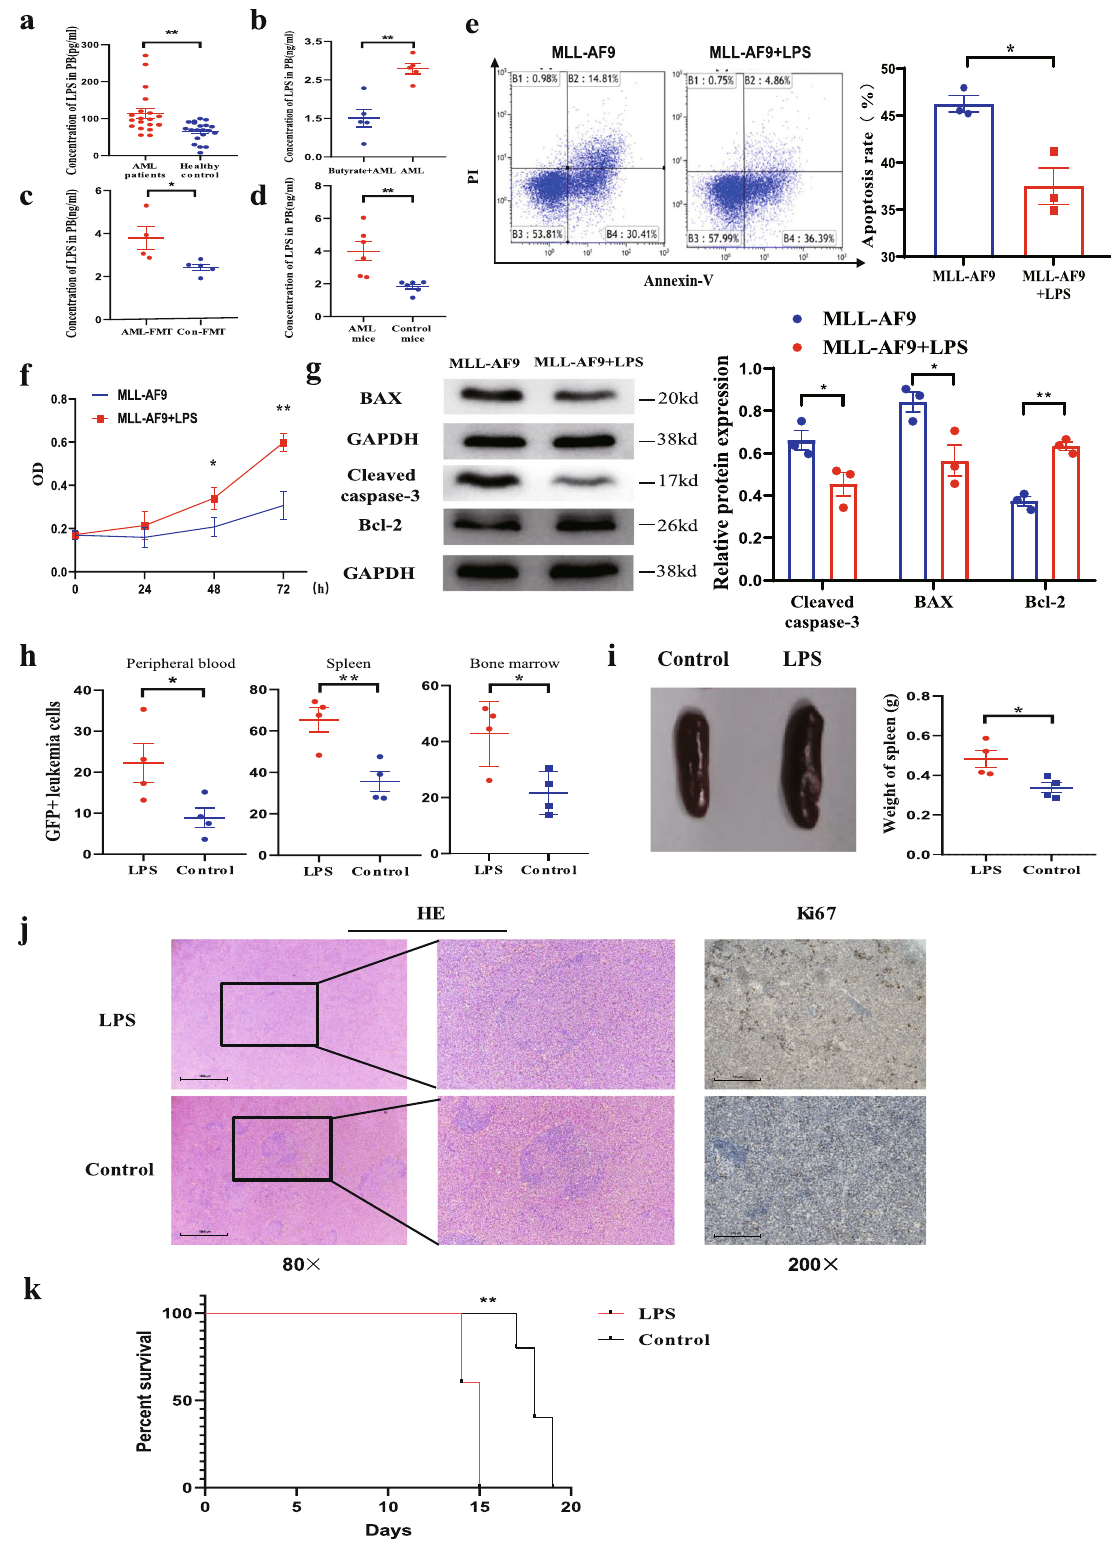
volume of 10 μ L. PCR conditions were as follows: 95 °C for 10 min, followed by 40 cycles of 95°C for 20 s and 60 °C for 1min. The primer sequences for the genes are shown in Supplementary Table 2. To determine the speci fi city of the PCRs, melting curves were routinely analysed. All experiments were conducted according to the manual ’ s instructions. Relative gene expression was expressed relative to that of the endogenous control GAPDH and calculated using the 2 – Δ CT